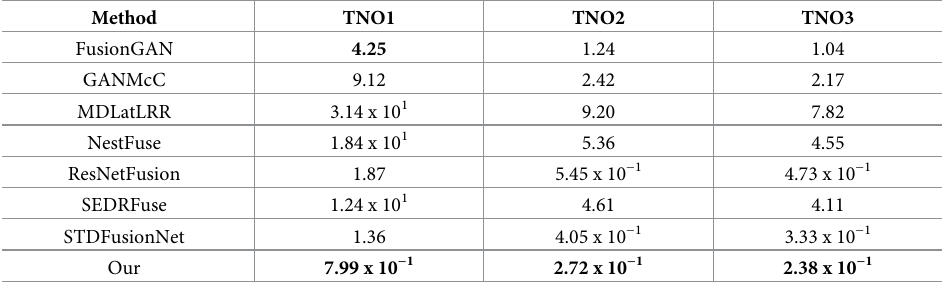
Table 2. Computational time comparison. All the experiments were performed on the CPU. (unit: